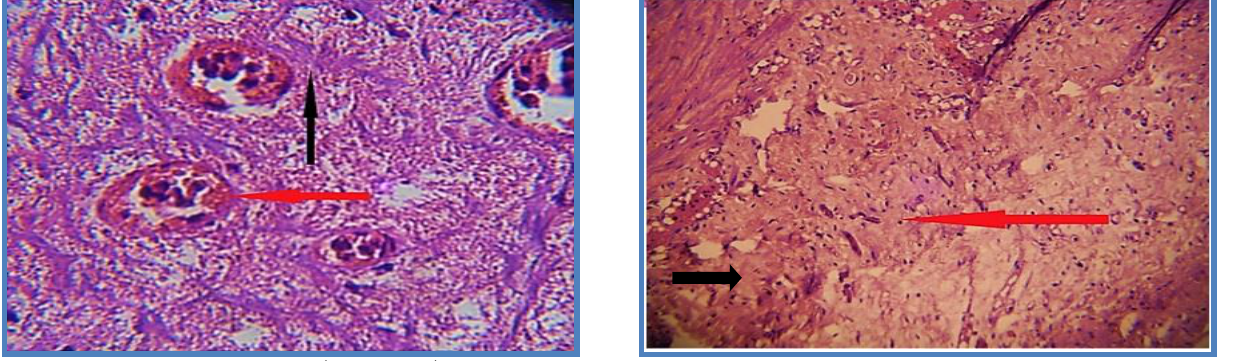
Figure, 9: Irregular collagen fiber (black arrow) and congested blood vessels with neutrophil in there lumen (red arrow) at 15 th day in goat of group A (H and E stain 40 X).